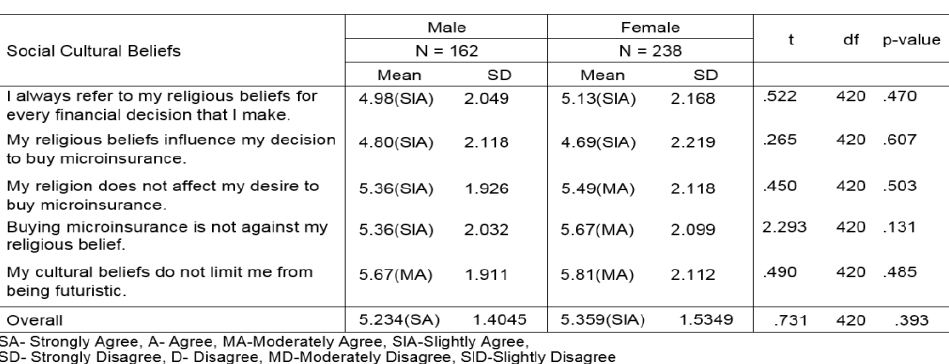
Table 1: Level of Agreement of the Respondents on the Social Cultural Beliefs on Microinsurance When Grouped According to Gender